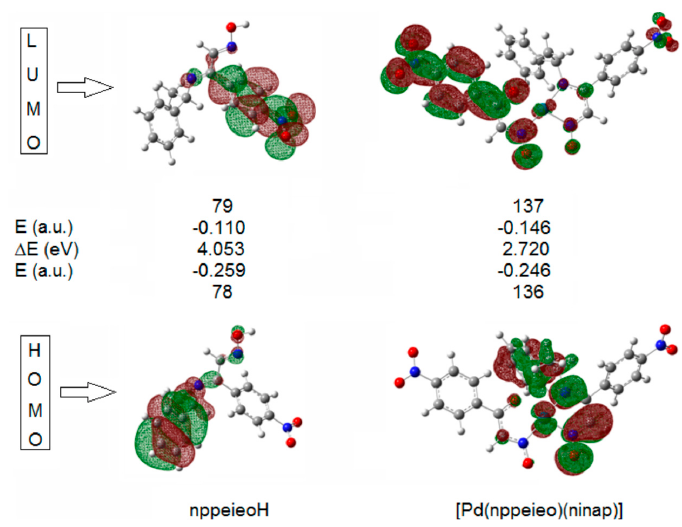
Figure 6. Frontier molecular orbitals of nppeieoH and its palladium(II) complex.